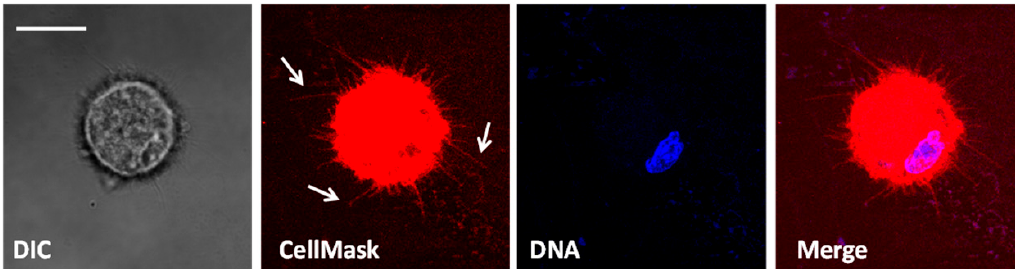
Figure 2. Live CTCs isolated with Parsortix technology. Whole blood was taken from a stage IV metastatic breast cancer patient. The Angle Parsortix was used to isolate CTCs from the blood (15 CTCs in 10 mL). CTCs were tethered to proprietary PEM + Lipid slides and stained with CellMask membrane dye (red). Cells are CD45 - and contain a nucleus (blue). Arrows indicate microtubule-based structures termed Microtentacles (McTN).